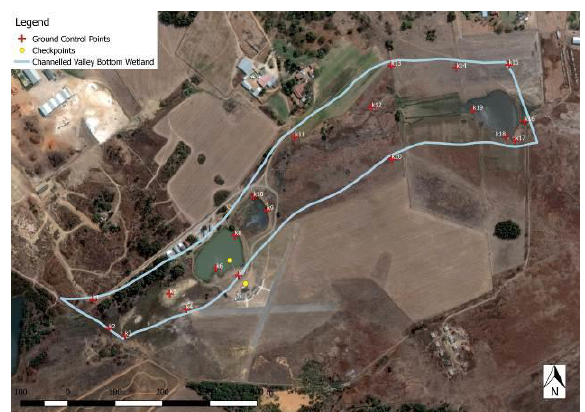
Figure 2. Ground control markers, checkpoints and position of the wetland.